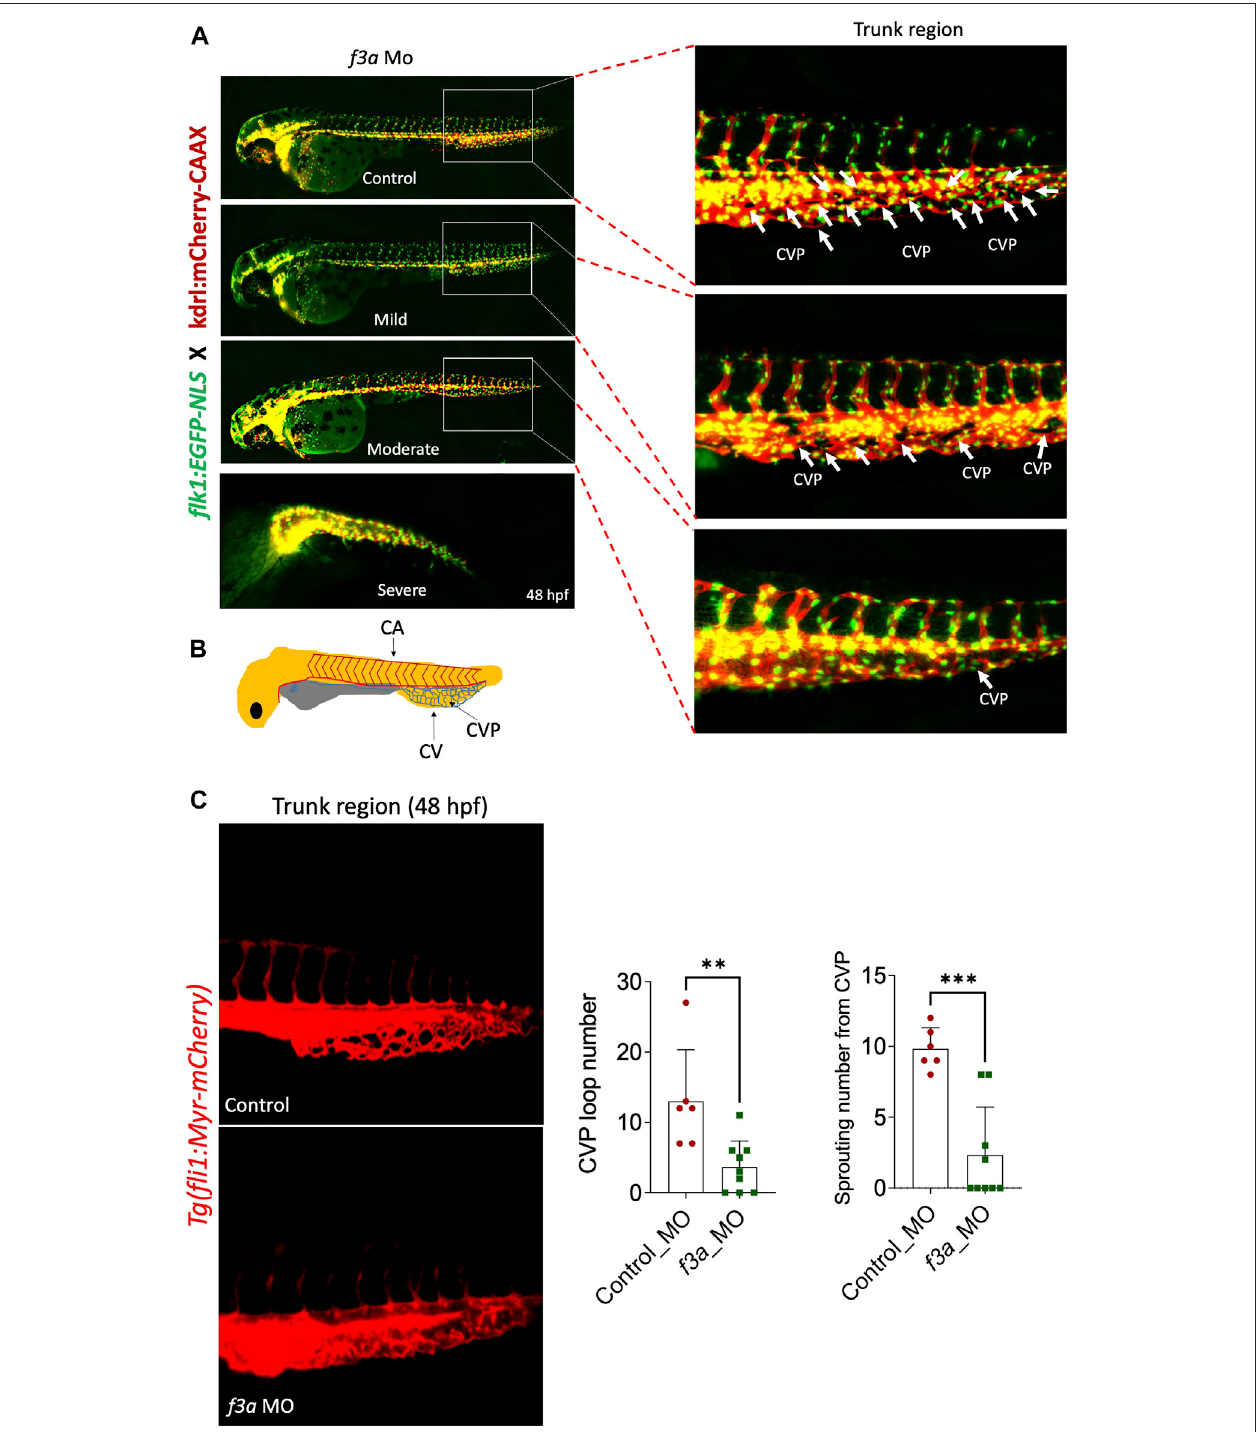
FIGURE 5 | f3a knockdown shows delayed angiogenesis: To study vascular development, endothelial-speci fi c transgenic lines of zebra fi sh ( fl k1:egfp-NLS/kdrl: mCherry-CAAX ) embryo were used to knockdown f3a . (A) Images represent MO-mediated knockdown of f3a expression resulting in morphological abnormalities. MO phenotypes: controlMO injected (control MO), and mild, moderate, and severe phenotypes. Differences incaudal vein plexus (CVP) in thetrunk regionsare indicated by whitearrows. (B) SchematicdiagramdepictstoidentifyCaudalvein(CV),caudalveinplexus(CVP)andCentralaorta(CA). (C) Tg( fl i1:Myr-mCherry) linewasusedto quantify CVP loop number and Sprouting number from the CVP at 48 hpf. Embryos were randomly picked from ~60 MO-injected (6 from control and 9 from f3a MO) embryos from control and f3a .